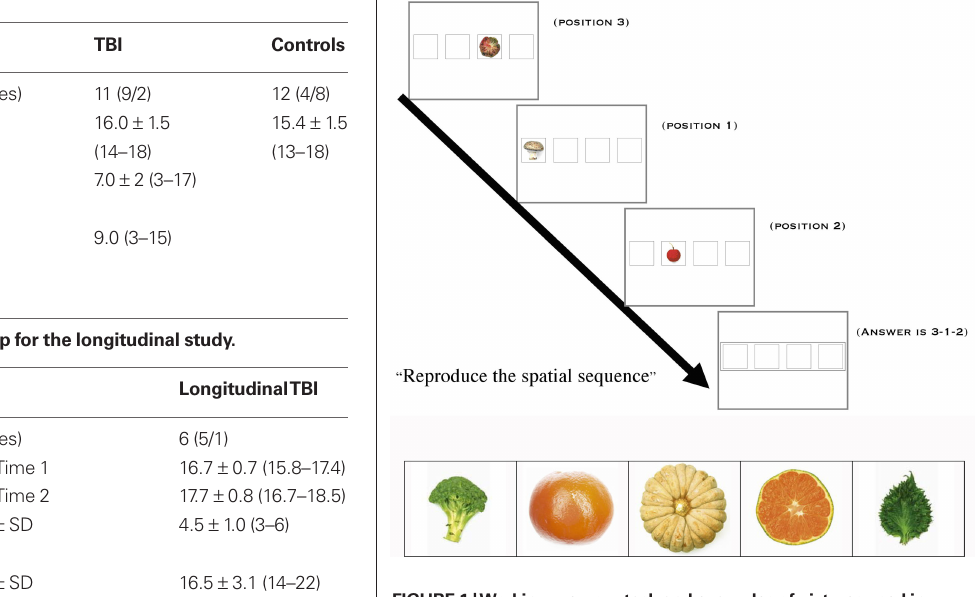
FIguRe 1 | Working memory task and examples of pictures used in the